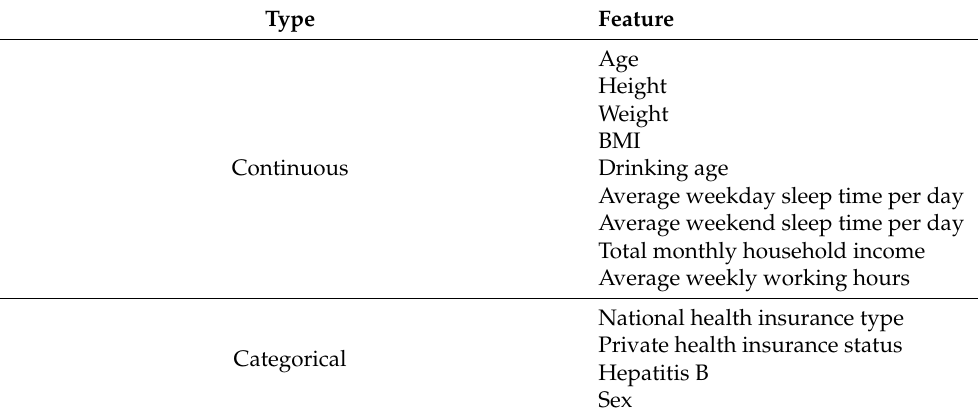
Table 1. Input features for the proposed methods. There are nine continuous features and three categorical features.